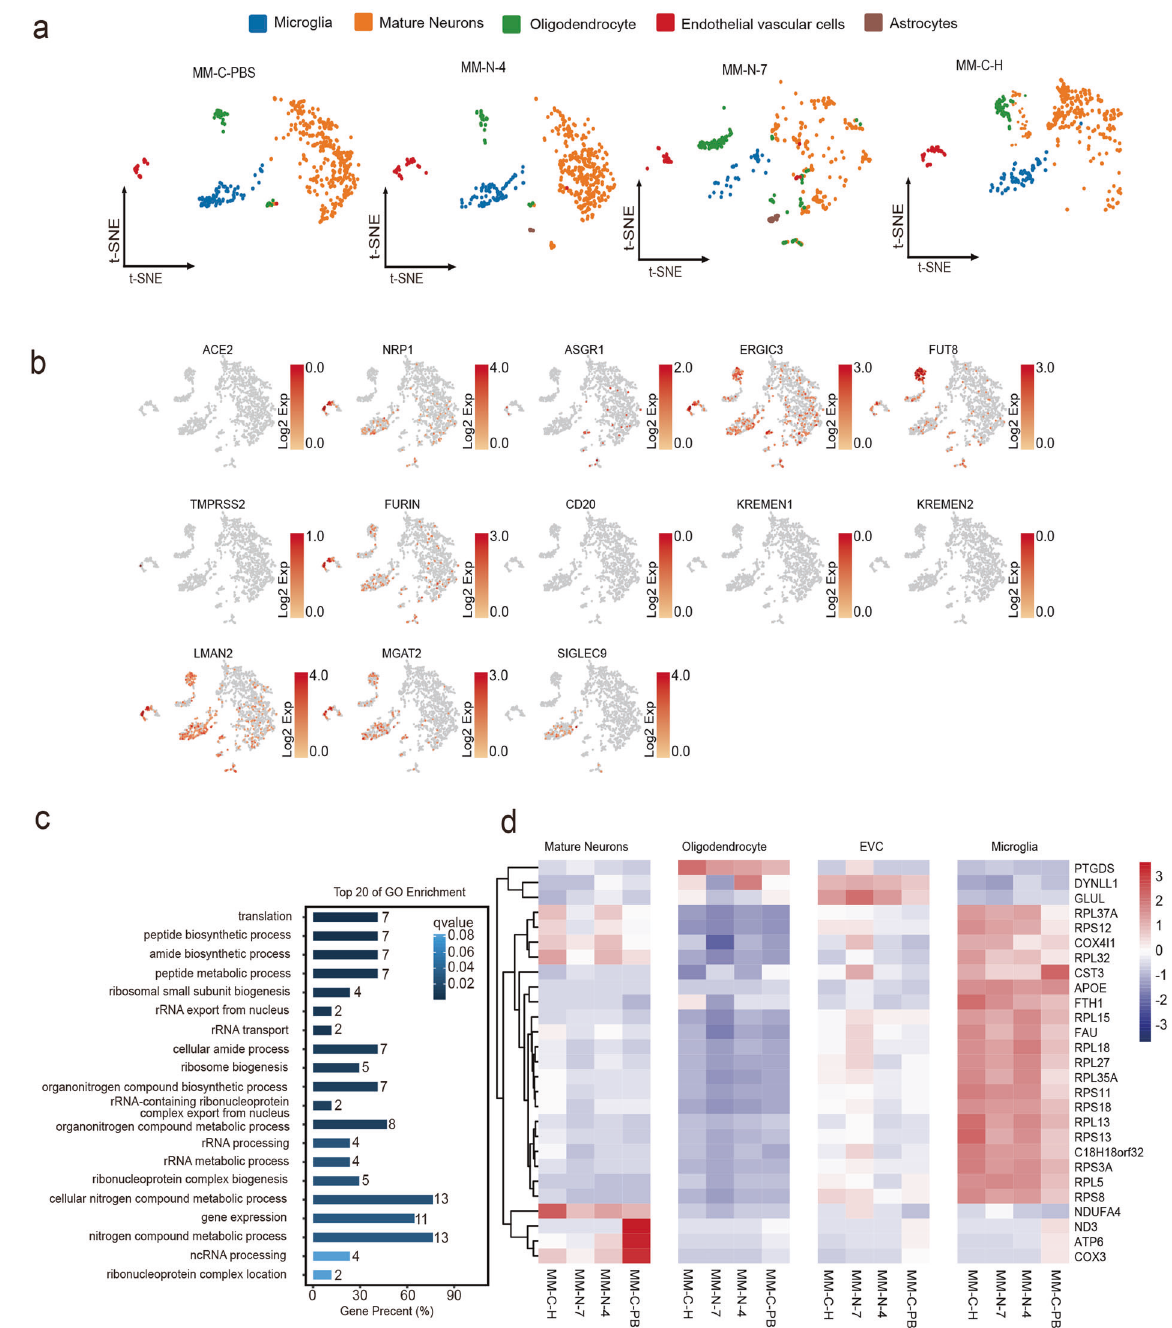
Fig. 4 CNS cells in hippocampus undergo a hyperbiosynthetic, hypermetabolic, and mitochondrial disorders in response to SARS-CoV-2 infections. a t-SNE projection of cells from single-cell sequencing. b Heatmap of receptor genes for SARS-CoV-2 in the hippocampus of rhesus macaques. c Enriched GO terms in SARS-CoV-2-infected hippocampus and SARS-CoV-2 compared with control. d Heatmap of differentially expressed genes (DEGs) from the hippocampus infected with SARS-CoV-2 compared with endothelial vascular cells, and astrocytes; ASGR1 in mature microglia, mature neurons, oligodendrocytes, endothelial vascular neurons, endothelial vascular cells, and astrocytes; and SIGLEC9 cells, and astrocytes (Fig. 4a and Supplementary Fig. S4a). Then 13 only in microglia (Fig. 4b). potential host factors were further analyzed in these cells of the To investigate the underlying molecular mechanisms, we hippocampus according to the reports by Gu et al. 24 and Cantuti- further examined the transcriptomic pro fi le of SARS-CoV-2- Castelvetri et al. 20 We found very low levels of TMPRSS2 (Fig. 4b), infected tissues (Supplementary Fig. S4b). Gene ontology (GO) consistent with the results from the CNS-derived cell lines by qRT- analysis showed that SARS-CoV-2 infection induced the enrich- PCR (Supplementary Fig. S3a). In the fi ve cell types we analyzed, ment of genes corresponding to translation, along with enrich- ERGIC3, LMAN2, and MGAT2 have relatively high levels of ment for biosynthetic processes, including peptide, amide, expression. NRP1 was expressed in microglia, mature neurons,